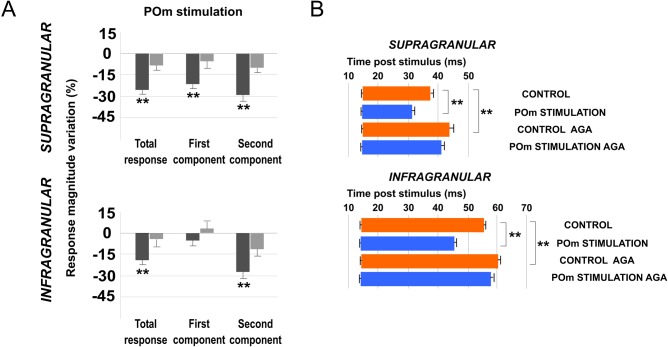
POm E-stimulation before whisker stimulus does not decrease cortical response magnitude and duration when AGA is applied in L1.(A) Percentage change in mean response magnitude by POm E-stimulation before (black) and after AGA application (grey). POm E-stimulation before each stimulus (500 ms) did not decrease cortical responses when P/Q-type voltage-gated calcium channels were blocked. (B) AGA application in L1 increased whisker offset response latency in infra- and supragranular layers. POm E-stimulation did not decrease cortical response duration when P/Q-type voltage-gated calcium channels were blocked. Control (orange) and POm E-stimulation (blue) conditions are shown.